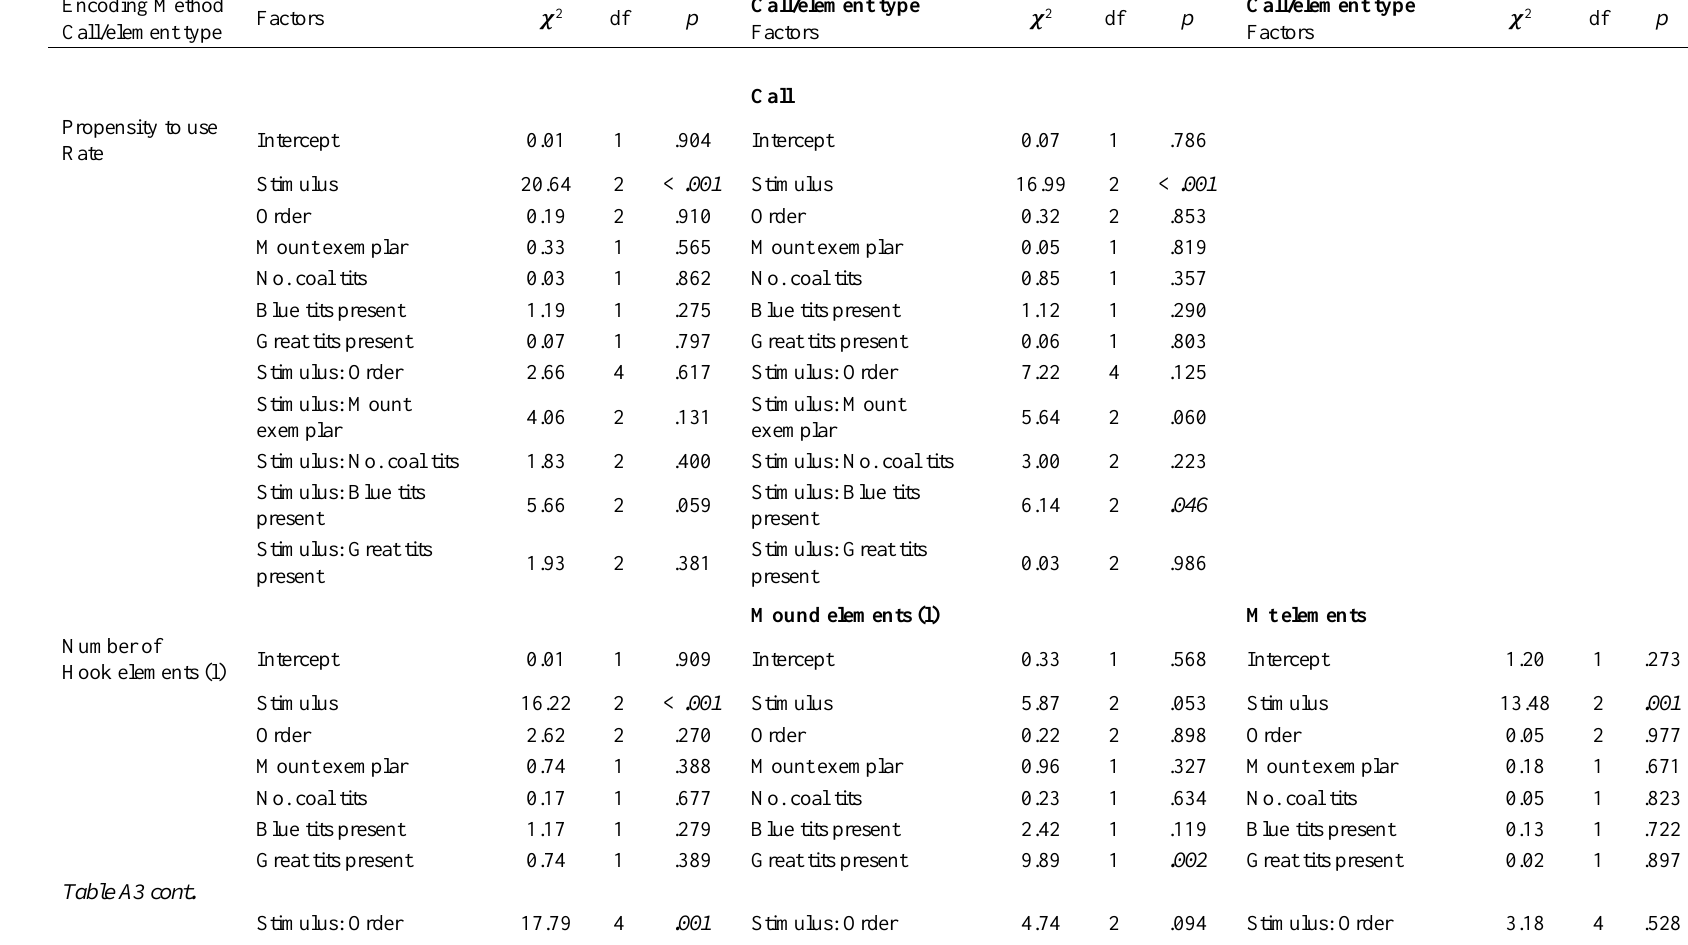
Test Results for Generalized and Linear Mixed Models Testing for Predator Type, Group Size (Conspecific and Flock Size) and Composition (Presence of Blue, Great, and Coal Tits) on Ways of Encoding Information about Predator Threat for Coal Tits. L And Bc Indicate that Data was Log (L) Or Box-Cox (Bc) Transformed if Residuals were not Normal for Linear Mixed Models. Bonferroni Corrected P-Values Based on the Number of Models are